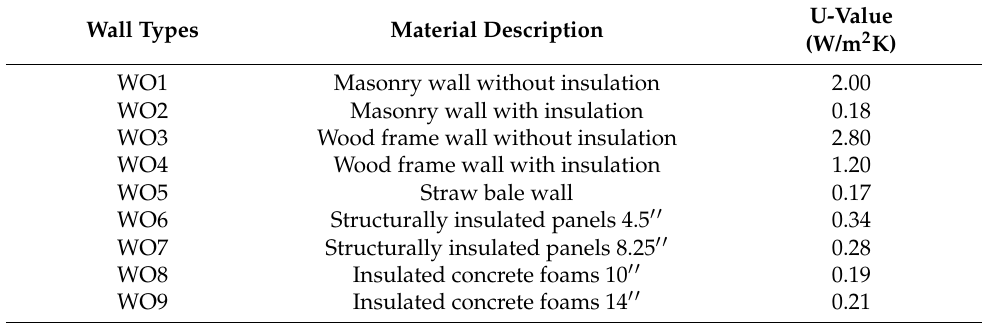
Table 4. Different types of wall materials for office building.